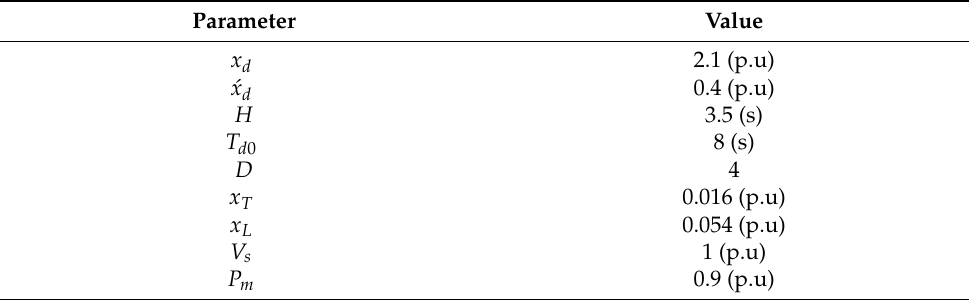
Table 1. Parameters of the studied SG model